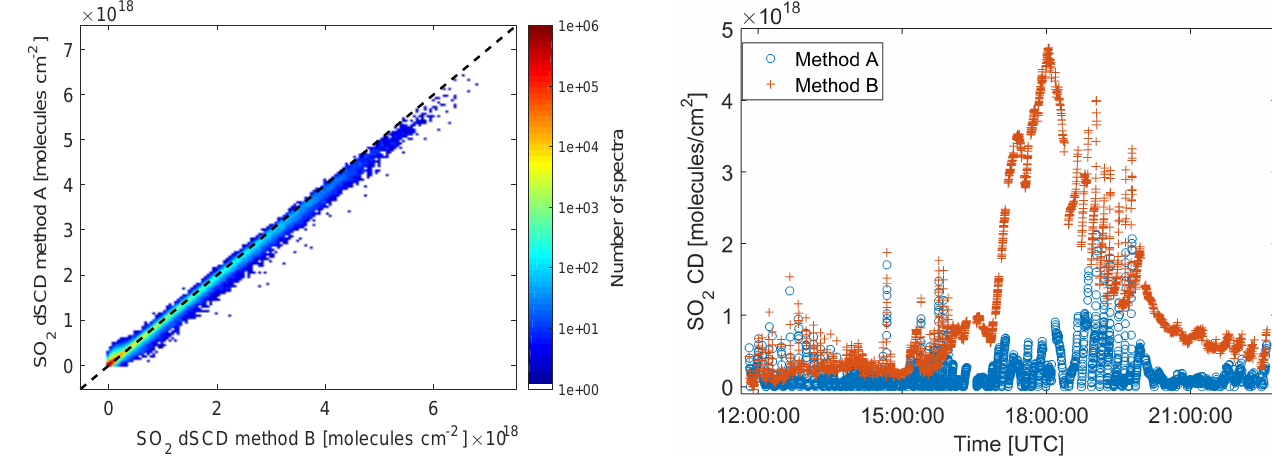
Figure 6. Two-dimensional histogram of the SO 2 SCDs from the solar atlas method vs. the SCDs from the NOVAC evaluation for instrument D2J2201 at Nevado del Ruiz. For this figure an offset value was subtracted from the solar atlas SO 2 CDs as well. The dSCDs of both methods show a good linear relationship with a slope close to 1 (0.956 in this case). The black-dashed line shows the identity line.